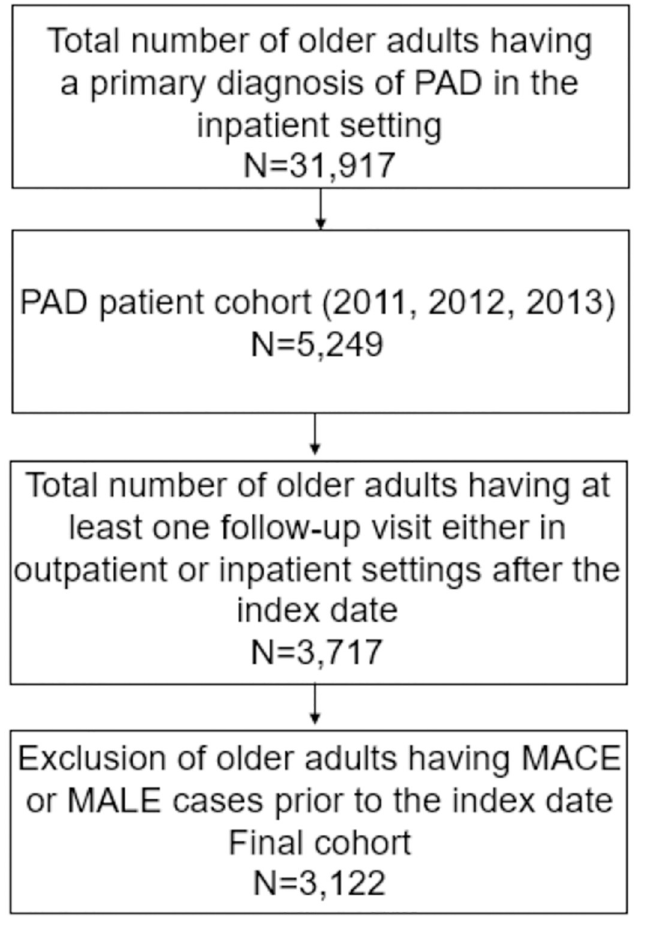
Fig 1. Flow diagram of the cohort selection